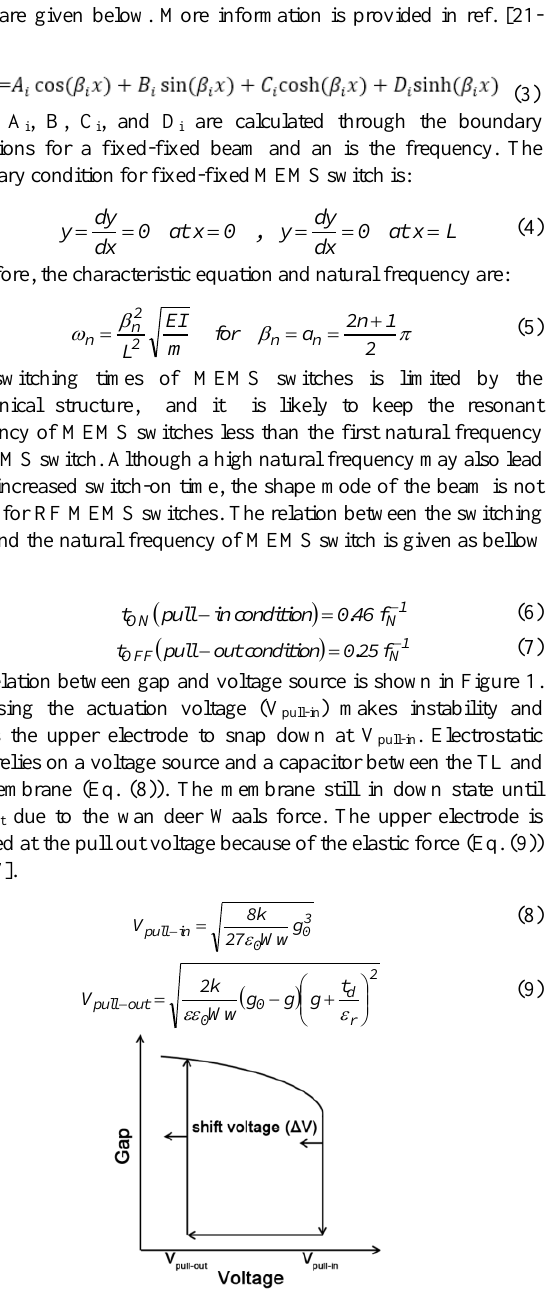
Figure 1. V pull-in and V pull-out of RF MEMS